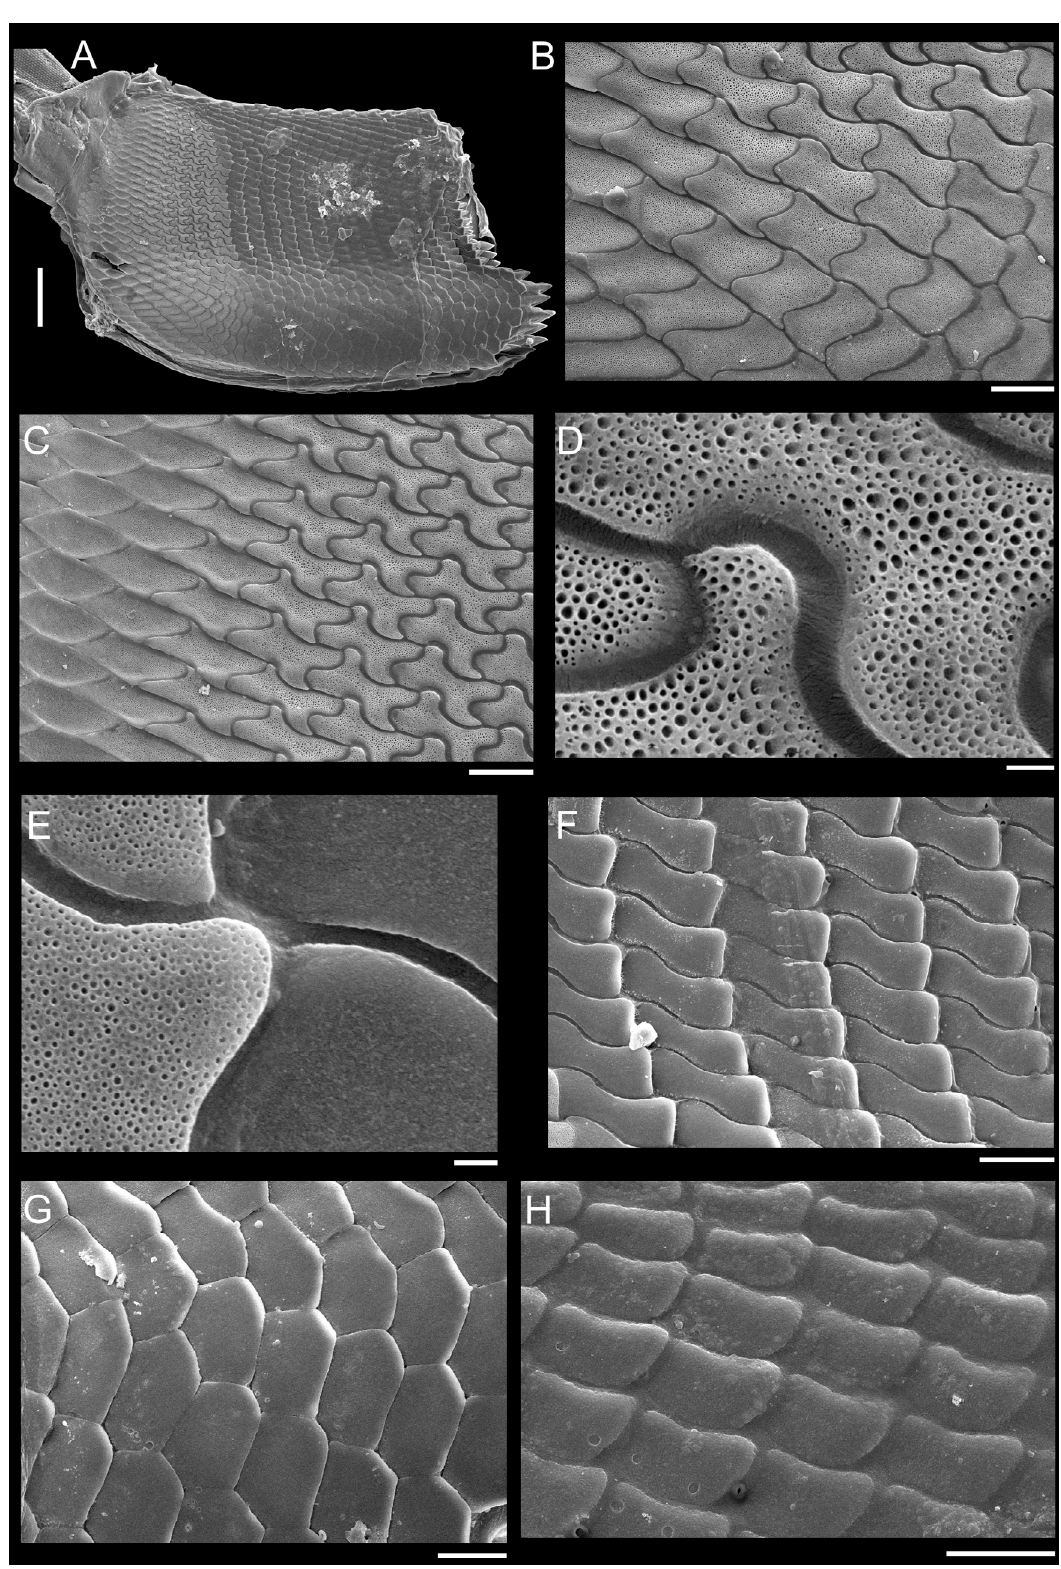
Fig. 16. Monophorus olivaceus (Dall, 1889). A–H . MNRJ 34028, jaw (outer side). Scale bars: A = 50 µm; B–C, F–H = 10 µm; D–E = 1